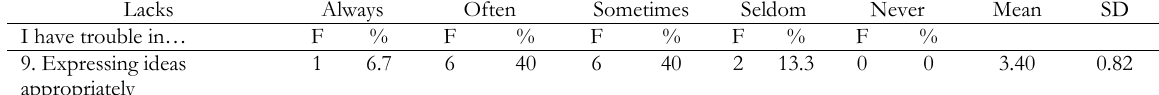
TABLE 8. S tudents’ perception of their writing